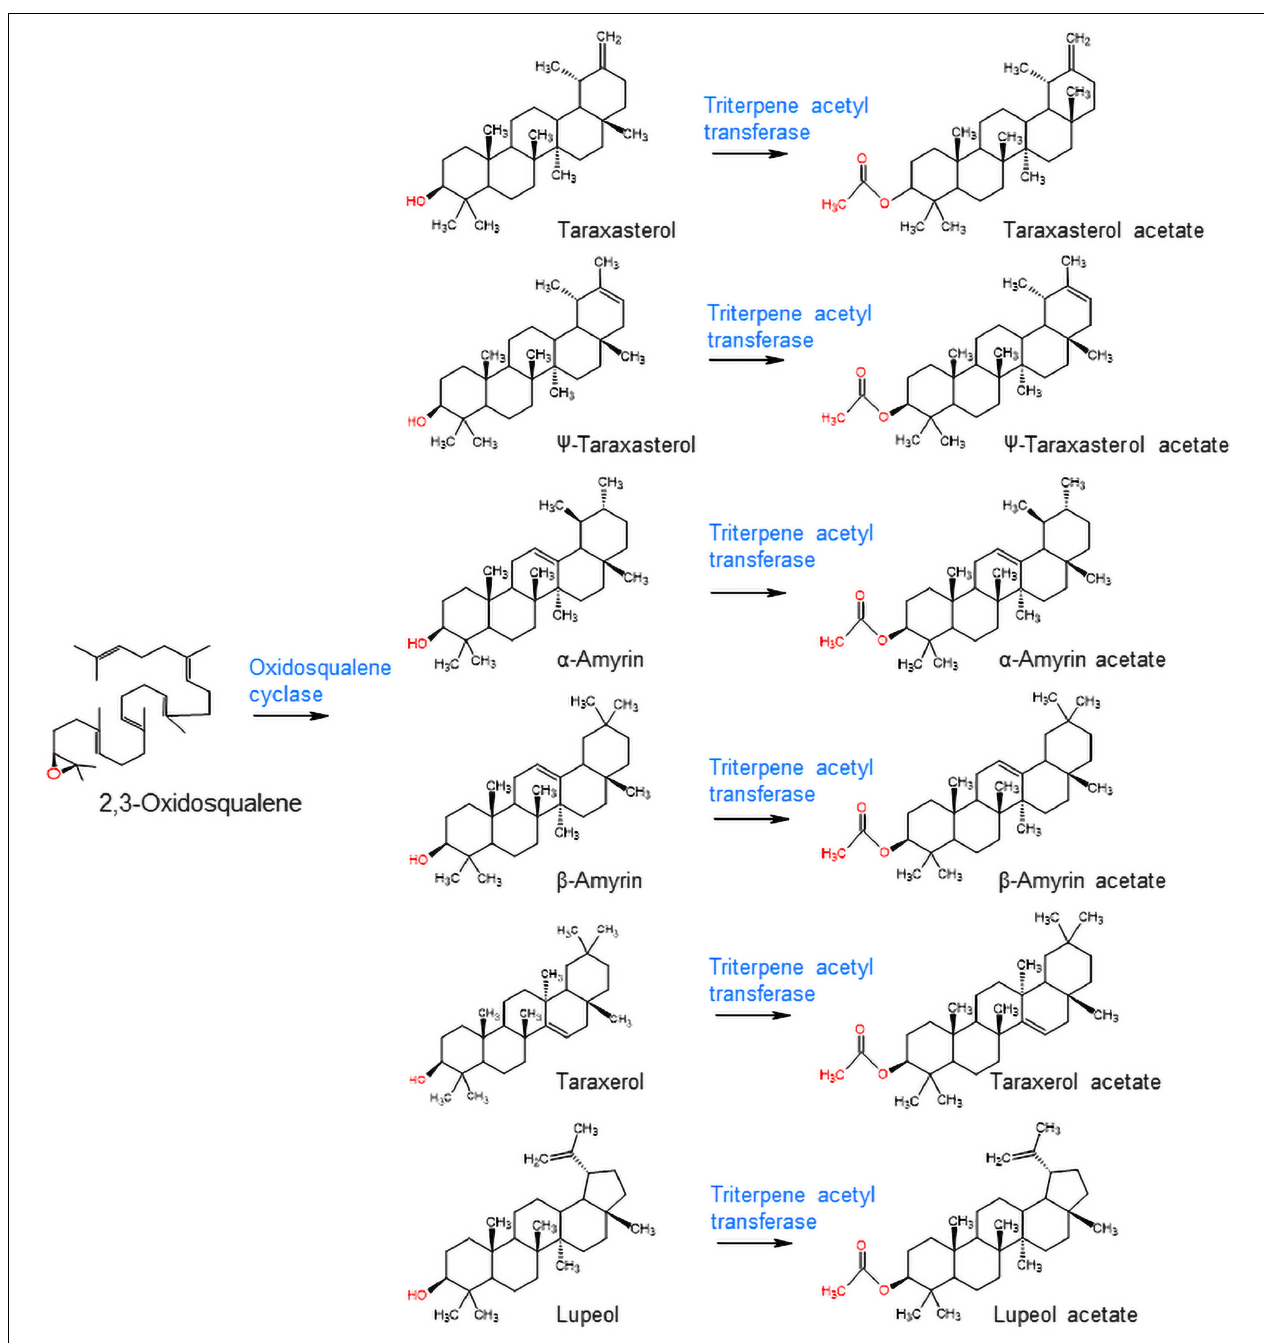
FIGURE 2 | Biosynthesis of triterpene acetates from free triterpenes by oxidosqualene cyclase and triterpene acetyltransferase in lettuce.